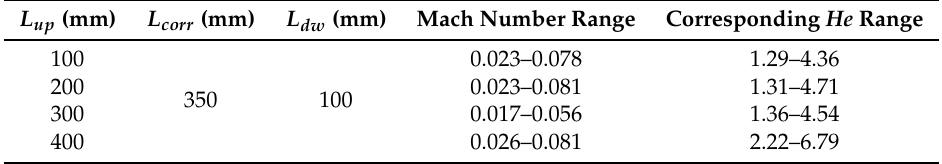
Table 15. Mach number and corresponding Helmholtz number ( He ) range for pipe systems in Case b-II. L up